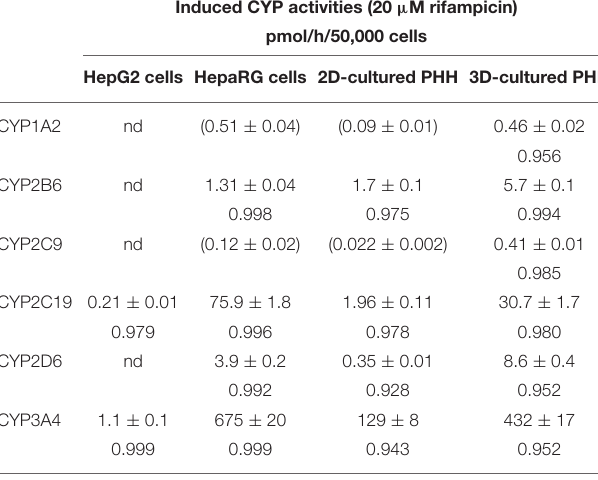
TABLE 3 | Induced CYP activities. Induced CYP activities (20 µ M rifampicin) pmol/h/50,000